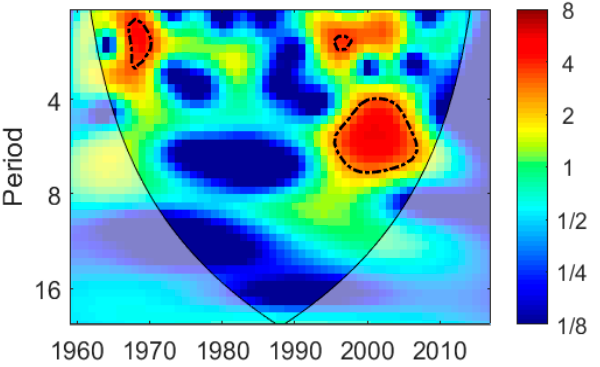
Figure 4. Wavelet power spectrums of the first two time coefficients. The dashed lines indicate that the wavelet power spectrums enclosed by them passed the confidence test at the 0.05 level. The thin black line represents the influence cone, beyond which the wavelet power spectrums are invalid. The unit of the power spectrums is dimensionless power/variance ratio.